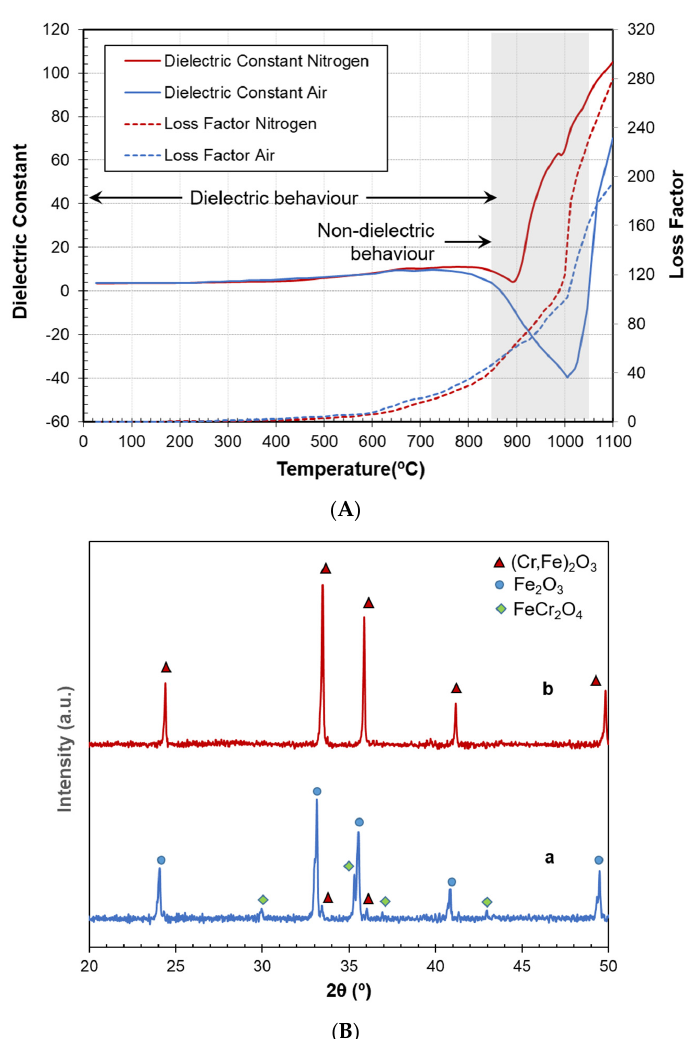
Figure 4. ( A ) Permi tt ivity measurements of the raw material mixture during the microwave synthe- sis of the pigment in air and nitrogen atmosphere; ( B ) XRD pa tt erns of both processed pigments. a: Microwave-processed sample in nitrogen, b: microwave-processed sample in air. Microwave-processed sample in nitrogen, b: microwave-processed sample in